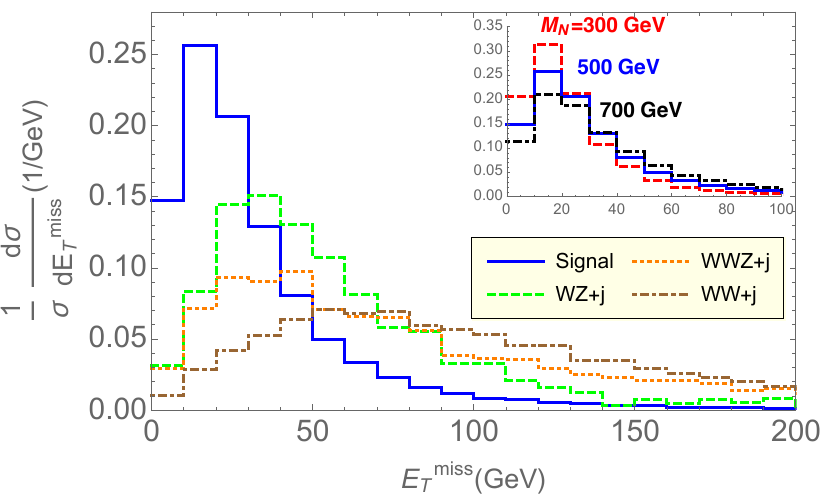
Figure 3 . Normalised di(cid:11)erential distribution of events as a function of missing transverse mo- mentum, after the application of the basic selection cuts; including p J for M N = 500 GeV along with all dominant backgrounds is shown. Inset shows the variations for three benchmark signal points with M N = 300 ; 500 and 700 GeV.